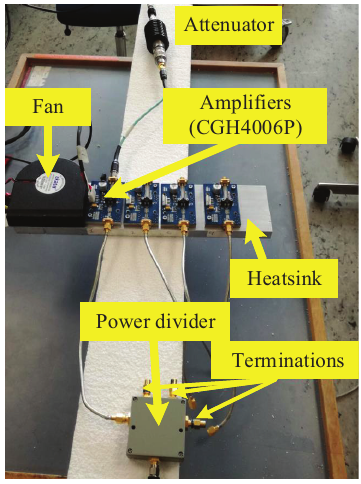
Figure 14. The experiment setup with multiple PAs.